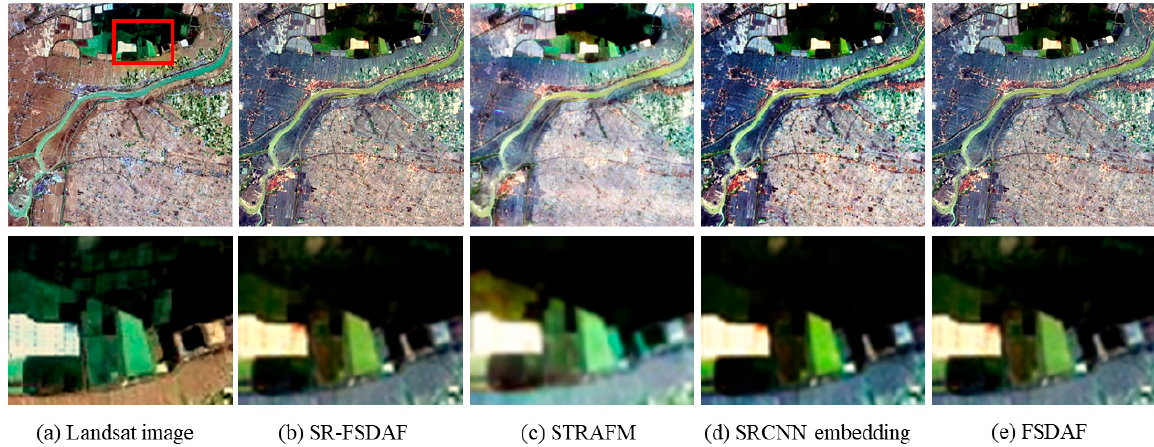
Figure 4. Comparison of the fused image and original Landsat image of non-heterogeneous mutations. ( a ) The Original Landsat image. ( b ) Fused image based on the SR-FSDAF method. ( c ) Fused image based on the STARFM method. ( d ) Fused image based on the SRCNN embedding method. ( e ) Fused image based on the FSDAF method.